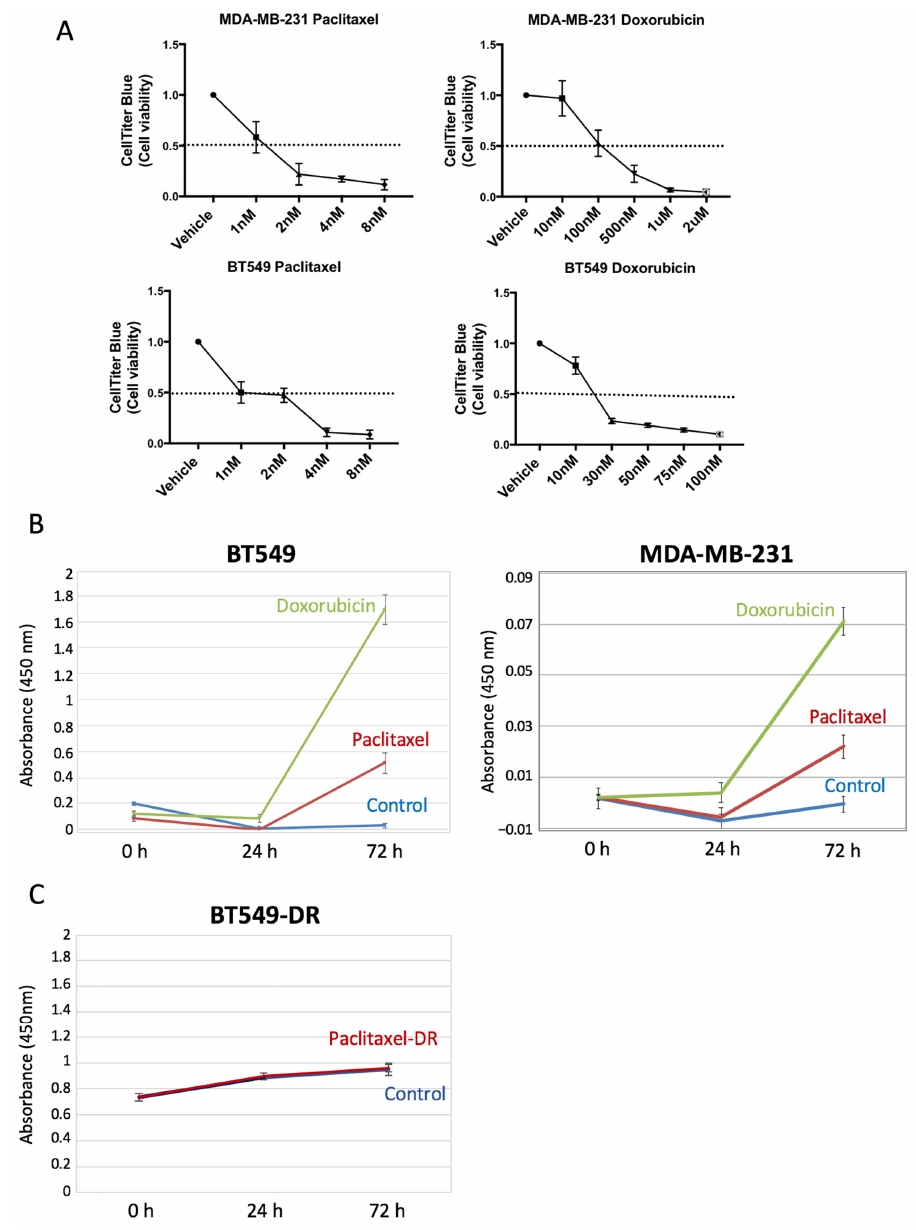
Figure 3. SOD2 is released when BrCa cells are treated with chemotherapy. ( A ) MDA-MB-231 and BT549 cells were treated with paclitaxel and doxorubicin for 3 days to induce cell death and CellTiter was performed to assess cell viability. ( B ) SOD2 levels in conditioned media from cells treated with paclitaxel 4 nM and doxorubicin (30 nM for BT549 left panel and 2 µ M for MDA-MB-231 right panel) for 3 days were evaluated in triplicate measurements by ELISA. ( C ) SOD2 levels in conditioned media from BT549-DR cells treated with paclitaxel 4 nM were measured in triplicate by ELISA. Error bars correspond to the standard deviation from the mean of the